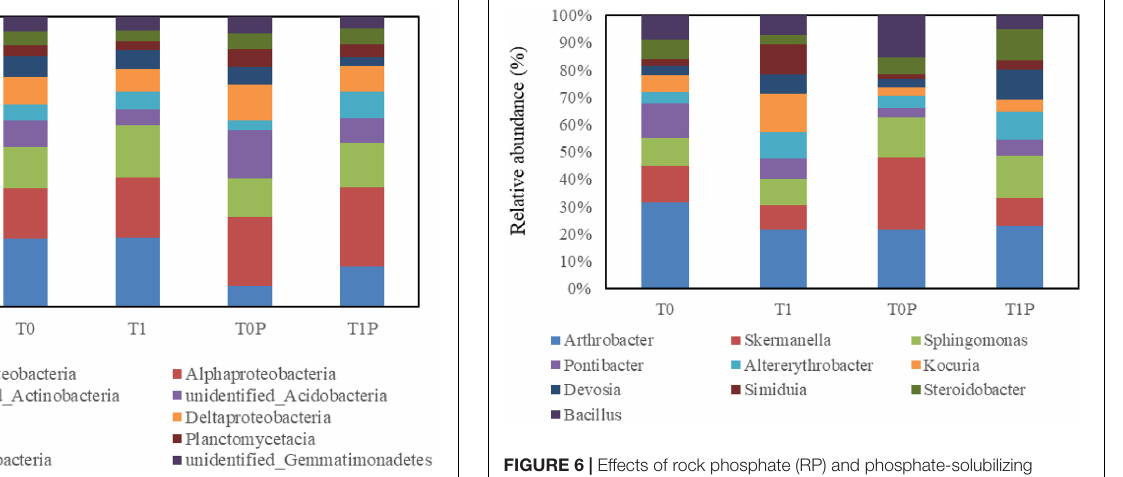
FIGURE 6 | Effects of rock phosphate (RP) and phosphate-solubilizing bacteria (PSB) on the relative abundance (%) of the 10 dominant genera of soil bacteria. The same 10 genera were dominant in all treatments. Treatments (following the treatment code is the replicate number): T0, no additions, the control; T0P, with PSB inoculation only; T1, with RP amendment only; T1P, with RP and